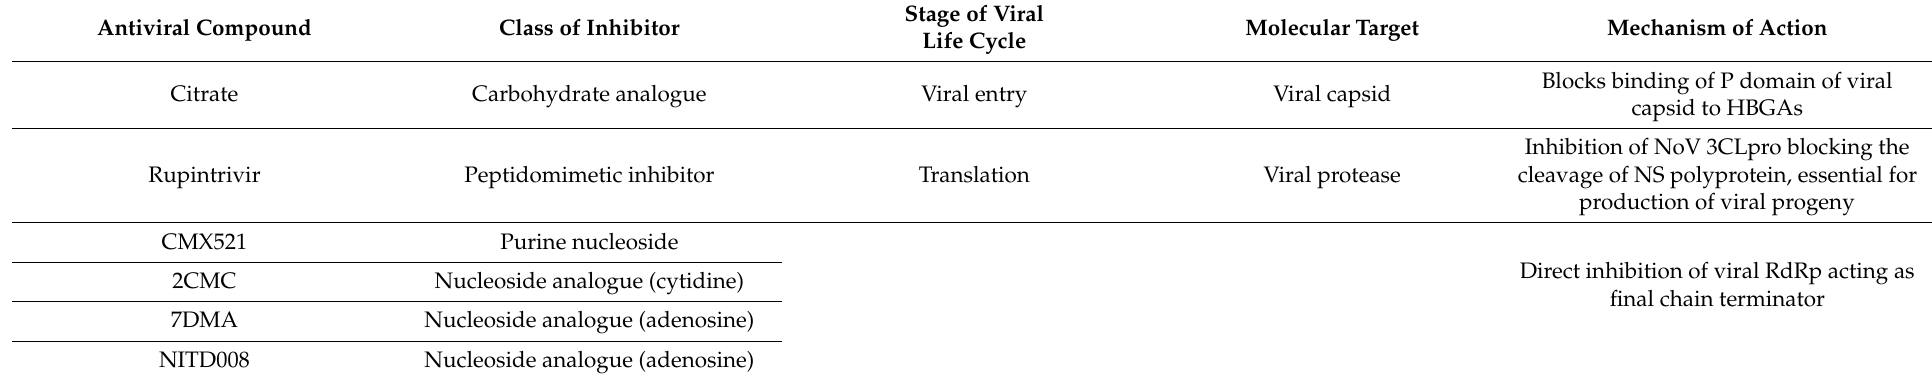
Table 2. Antiviral compounds for norovirus infections within this